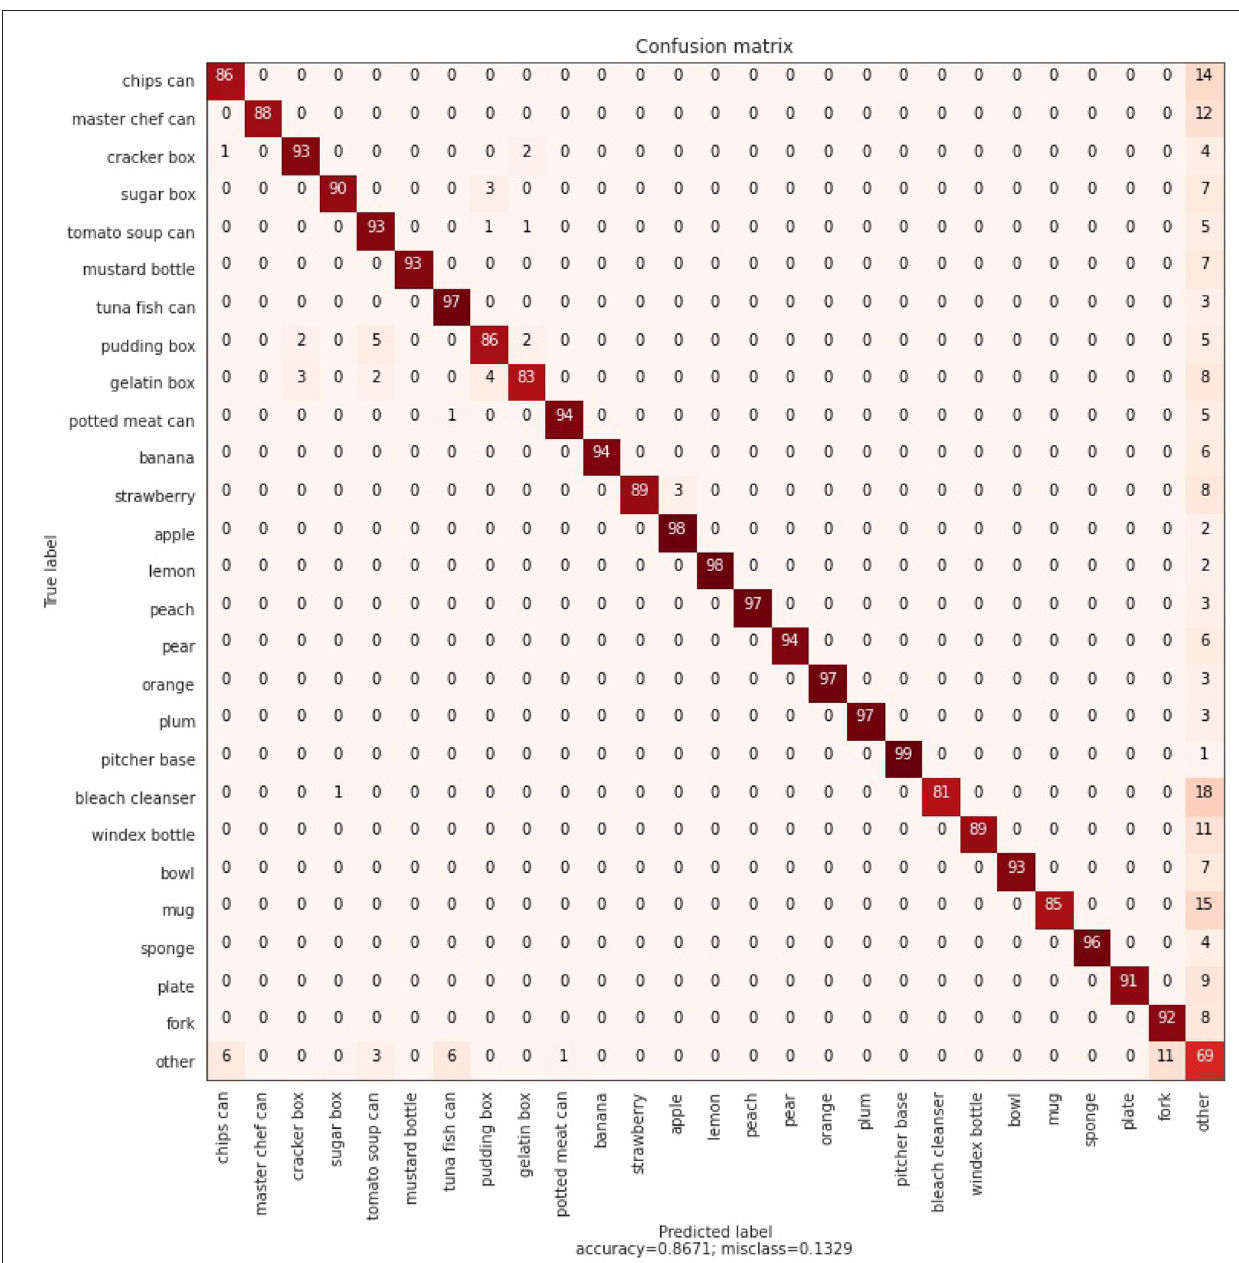
FIGURE 4 | Confusion matrix, using the max of a Dirichlet distribution and a likelihood based threshold over object beliefs as described in Section 2.3. 100 examples are classified for each class of the 26 known and 7 unknown objects. Overall, an average classification accuracy of 86.71% is achieved.